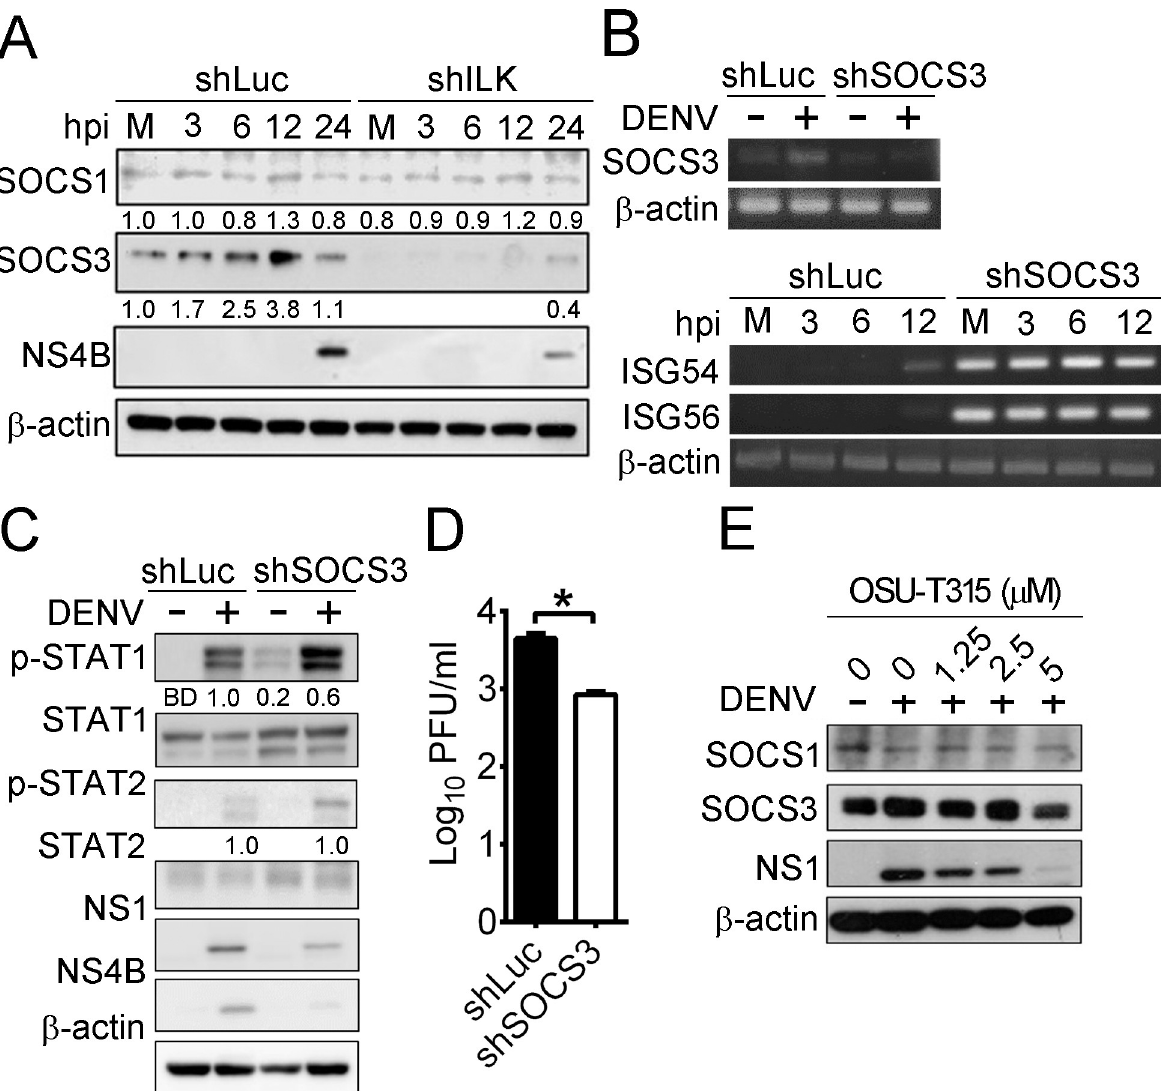
Fig 4. ILK regulates SOCS3 expression to attenuate IFN signaling. ( A ) Representative western blots of the indicated proteins in mock- (M) and DENV-infected control (shLuc) or ILK knockdown (shILK) A549 cells at indicated hours post-infection (hpi) are shown. The ratios of SOCS1 or SOCS3 to β -actin relative to mock-infected control cells are shown. ( B-C ) Representative RT-PCR images of the indicated genes ( B ) and western blots of phosphorylated (p-) and indicated proteins ( C ) in control and SOCS3 knockdown (shSOCS3) A549 cells infected with (+) or without (-) DENV at indicated or 24 hpi are shown. The ratios of phosphorylated to total STAT1 and STAT2 relative to infected control cells are shown. ( D ) The viral yields in indicated A549 cells at 24 hpi are shown. Data represent mean + SD (error bars). � p < 0.05. ( E ) Representative western blots of indicated proteins in A549 cells infected with (+) or without (-) DENV and treated with the indicated concentration of OSU-T315 at 24 hpi are shown. BD, below detection.